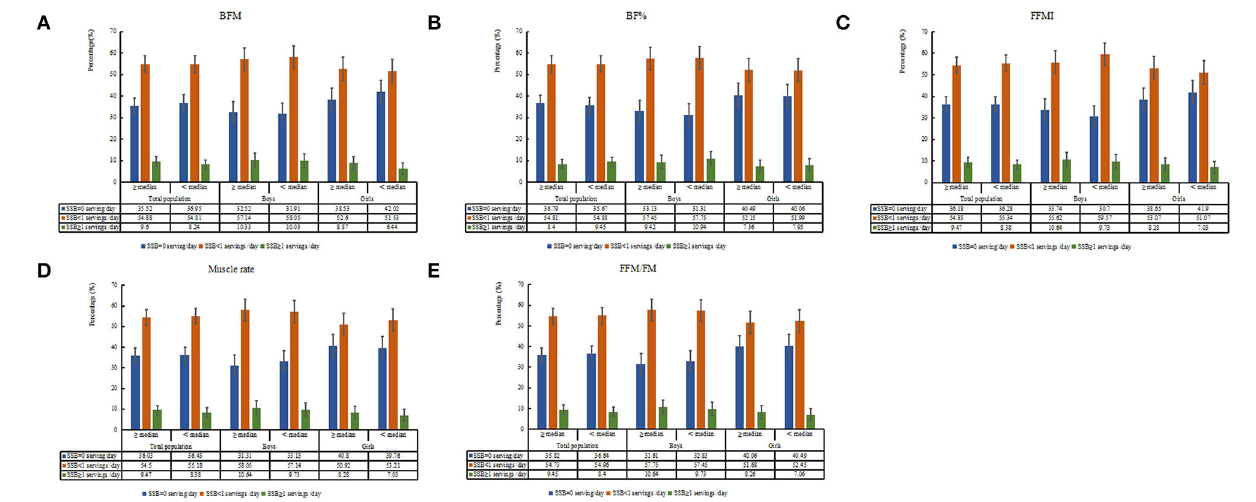
FIGURE 2 | Distribution of sugar-sweetened beverage (SSB) consumption grouped by body composition among total population and boys and girls, respectively ( A : BFM stratification; B : BF% stratification; C : FFMI stratification; D : Muscle rate stratification; E : FFM/FM stratification).